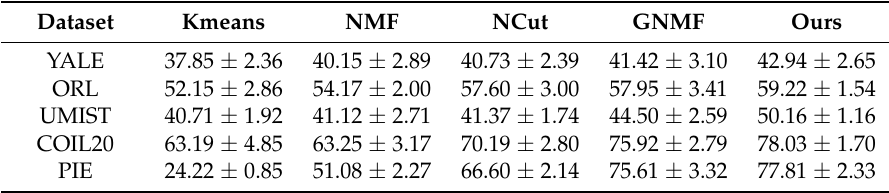
Table 2. Clustering Accuracy on the 5 datasets